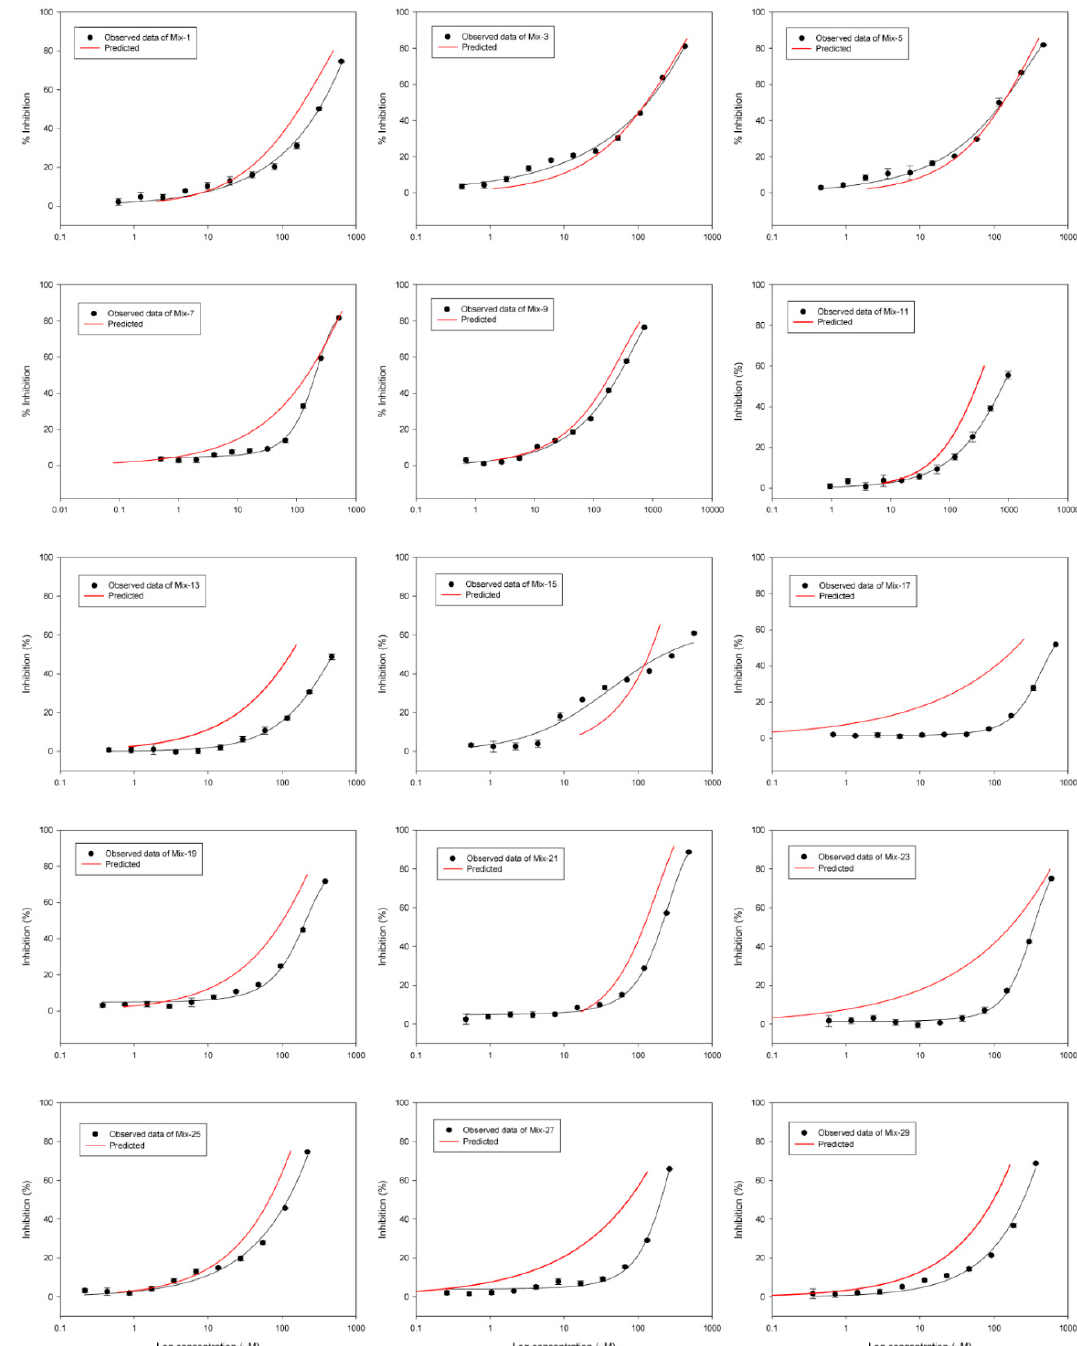
Figure 2. The DRCs for the observed bioluminescent inhibitions and the predicted inhibition (red lines) by the CA model for the binary equitoxic mixtures based on ratios at 50% effective concentrations for each component (the data points are geometric means ± standard deviation (SD) of experimentally observed data, and statistical best-fits for regression models are summarized in Table 3).